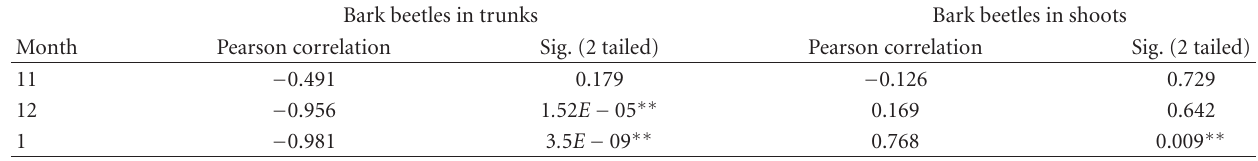
Table 1: The correlation between T. yunnanensis and T. minor in trunks and shoots of Yunnan pines. Bark beetles in